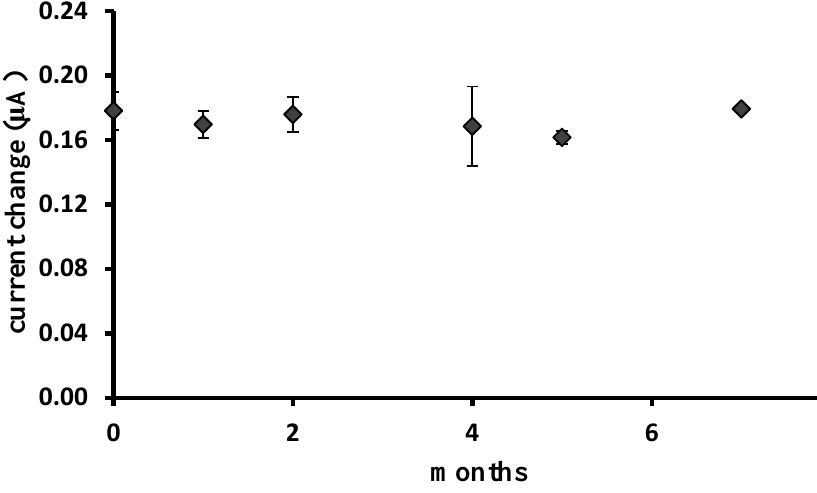
O and phosphate buffer pH 7/0.1 M 2 2